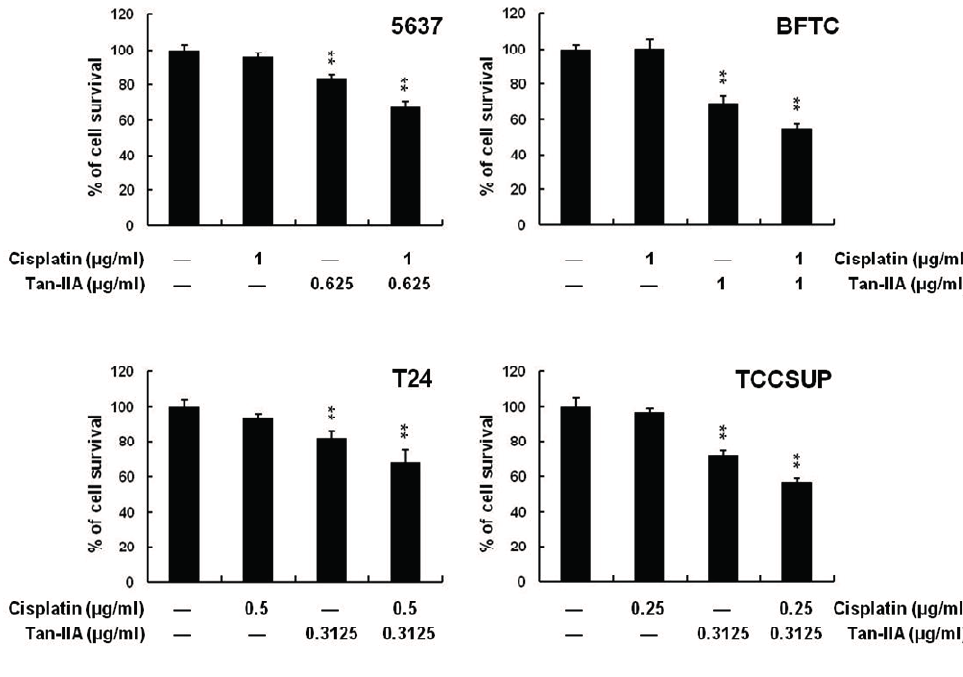
Figure 6. Effect of Tan-IIA on combination therapy with cisplatin. Human bladder cancer cells were treated with cisplatin or Tan-IIA only, or a combination therapy for 24 h, and analyzed with MTT assay. Data are presented as means ± S.D. from three different experiments. ** p < 0.01 versus